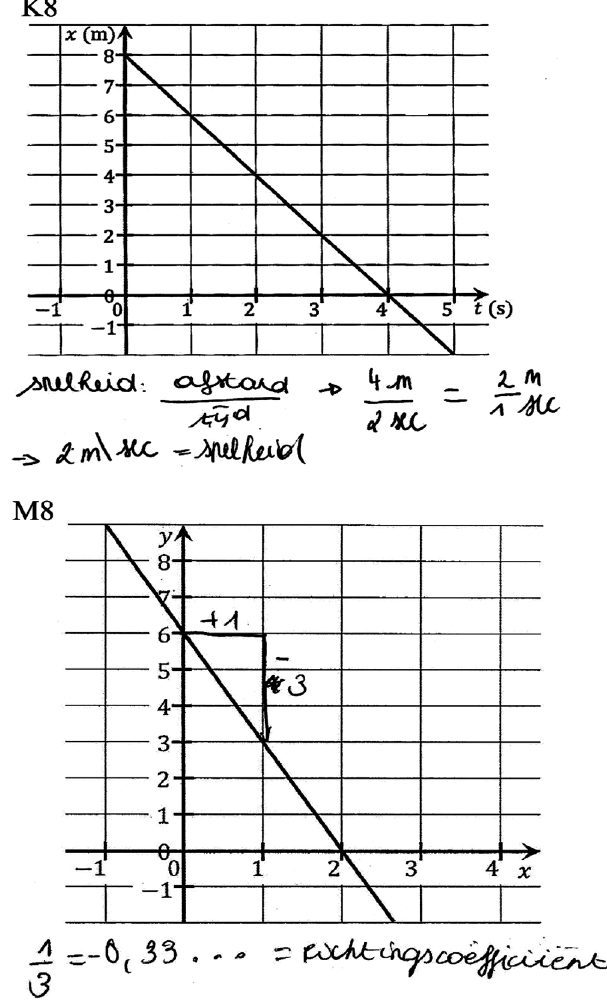
FIG. 15. Example of isomorphic questions K8 and M8 (with negative slopes) solved by the same student who answered the questions in Fig. 14. In K8, the interval or point confusion occurs and the minus sign is omitted. In M8 a triangle with horizontal step size of þ 1 is drawn and the minus sign is included. In K8, the text translates as “ velocity: distance/time . ”